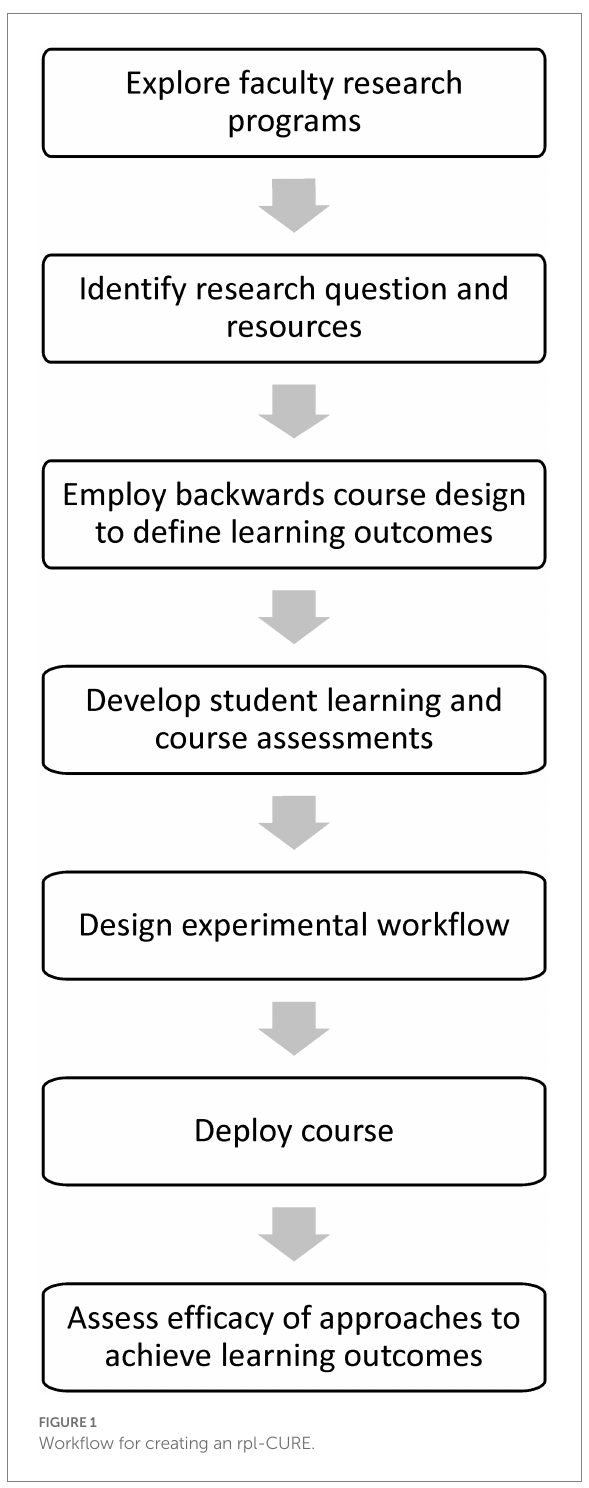
FIGURE 1 Workflow for creating an